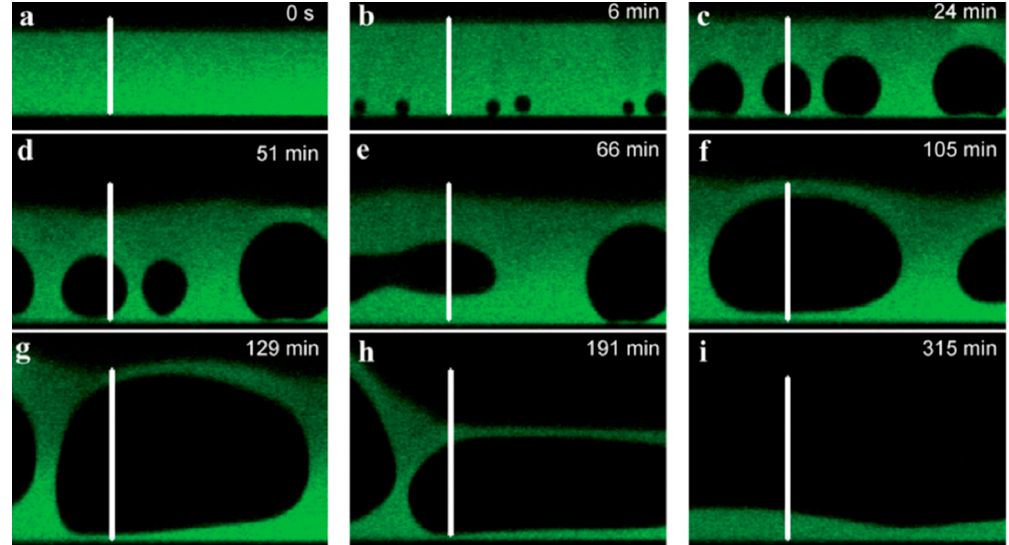
Figure 14. Vertical section of PEM observed by CLSM of a (PLL/HA) 50 /PLL FITC film built in 0.15 M NaCl and swelled by immersion in solutions of increasing NaCl concentrations, up to 0.48 M, followed as a function of time. The scale bars represent 50 µm for ( a , b , c ), 60 µm for ( d , e , f ), and 80 µm for ( g , h , i ). Figure taken from reference [167], Copyright © 2020 Royal Society of